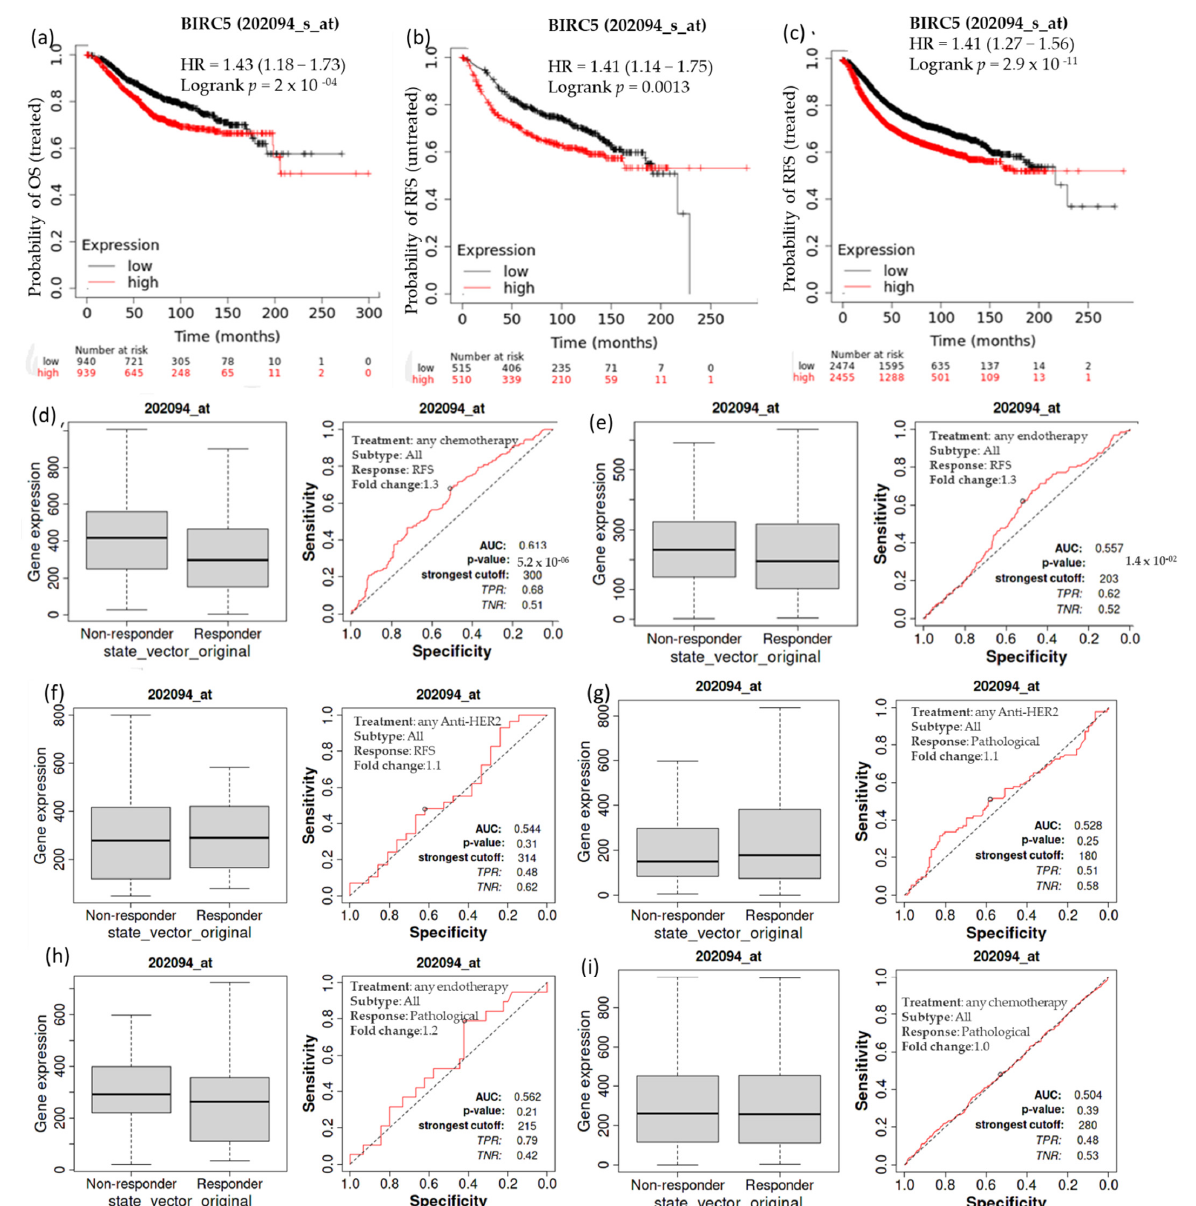
Figure 4. The relationship between BIRC5 expression, relapse-free survival, and complete patholog- ical response in BC patients. Compared to the low-expression group, the high-expression group had a median survival of 68.04 months as opposed to 121.2 months HR, 1.43; CI: 1.18 –1.73; p = 2 × 10 − 4 ) ( a ). Compared to the low-expression group, the high-expression group had an upper quartile sur- vival of 37.25 months as opposed to 66.23 months (HR:1.41; CI: 1.27 − 1.56; p < 2.9 × 10 − 11 ) ( b ). In com- parison to the BIRC5 low-expression systematically untreated patients, the high-expression group had a median survival of 37 months as opposed to 93.23 months of relapse-free survival (HR:1.41; CI: 1.14 − 1.75; p = 0.0013) ( c ) Patients receiving any form of chemotherapy ( d ) and any form of endo- therapy ( e ) demonstrated a significant decline in the expression of BIRC5, but patients receiving anti-HRE2 therapy did not display a significant difference ( f ). No discernible difference in the com- plete pathological response between patients receiving an anti–HER2 treatment ( g ), endotherapy ( h ), and chemotherapy ( i ) and those who were not receiving any treatment. OS-overall survival, RFS-relapse-free survival.